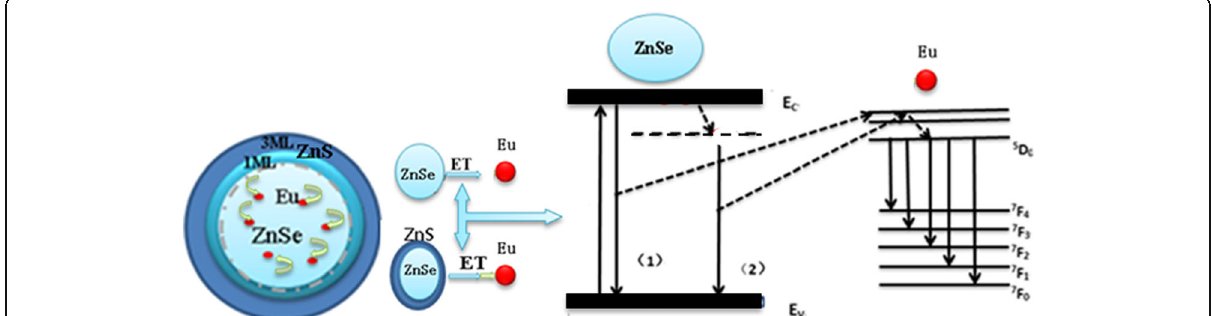
Fig. 3 Proposed energy transfer mechanism between ZnSe (donor) and Eu (acceptor) in ZnSe:Eu/ZnS QDs. (1) Band-edge-related radiation recombination process. (2) Defect-state related radiation recombination